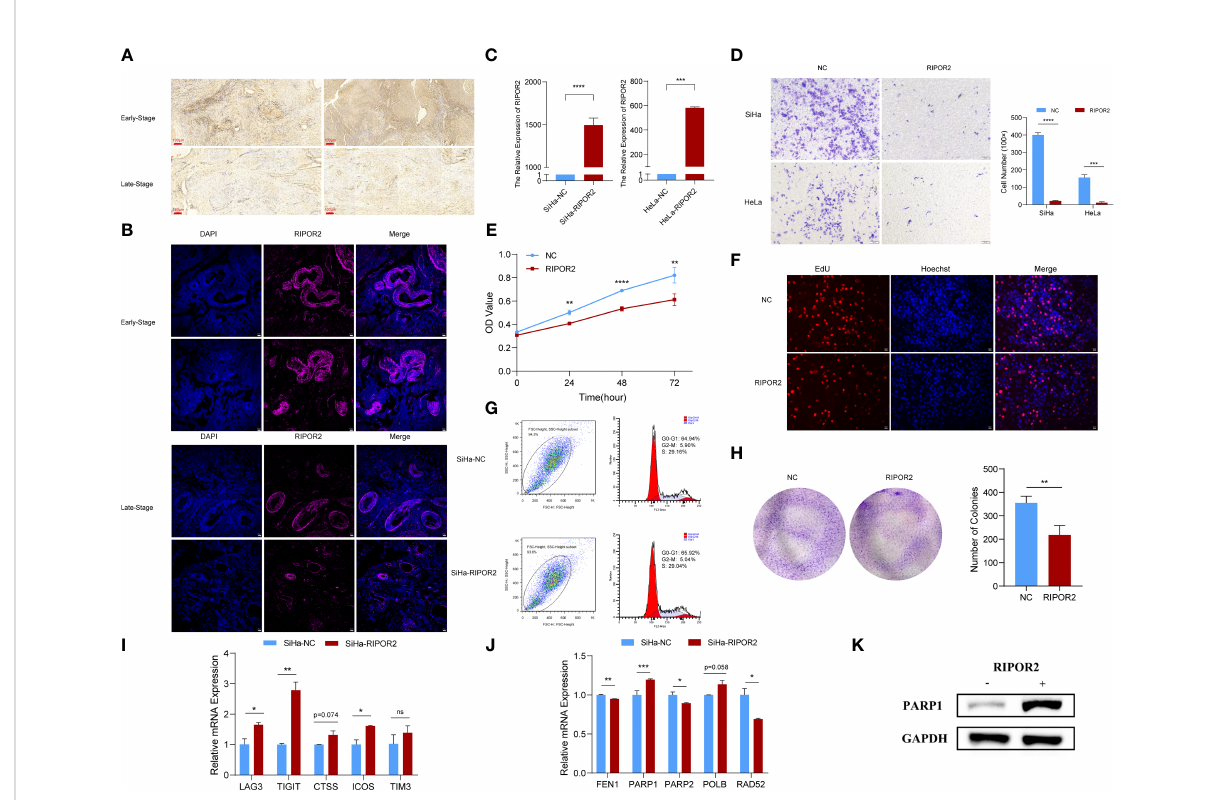
FIGURE 8 Functional experimental veri fi cation of RIPOR2. (A) The expression of RIPOR2 protein in early- and late-stage cervical cancer tissues was detected by Immunohistochemistry (IHC), Scale bar, 100 m m. (B) Immuno fl uorescence (I, F) staining results of RIPOR2 protein in early- and late- stage of cervical cancer tissues. Scale bar, 25 m m. (C) The expressing amount of RIPOR2 differed in the control cell lines and overexpression transfected cell lines, both in the SiHa group with p-value <0.0001(****) and the HeLa group with a p-value <0.001(***). (D) The results of the transwell assay, pictures on the left show the CC cell distributions of groups photographed in different visual fi elds. “ NC ” means normal control with pcDNA3.1 (empty vector) transfection; “ RIPOR2 ” represents a group with overexpression plasmid transfection. The result of differential analysis based on cell number was shown in the bar plot. (E) It is shown that at times of 24, 48, and 72 h, the HeLa cells living in the normal control group are always signi fi cantly greater than the RIPOR2-overexpressed group by CCK-8 (p-value: **p <0.01, ****p <0.0001). (F) EdU assay was used to detect the proliferation ability of each group of SiHa cells. Scale bar, 100 m m. (G) Flow cytometry analysis showed overexpression of RIPOR2 in SiHa cells slightly increased the percentage of the G0/G1 phase cells and decreased the percentage of S and G2/M phage cells. (H) Colon formation assay was performed to determine the proliferation ability of each group of cells. The bar plot showed the number of colonies in SiHa cells, with p <0.01 (**). (I) Inferred from RT-qPCR, checkpoints LAG3, TIGIT, CTSS, ICOS, and TIM3 showed correspondingly high expression in the SiHa cell lines transfected with RIPOR2-overexpressing plasmids. (J) RT-qPCR results indicated that FEN1, PARP2, and RAD52 negatively correlated with RIPOR2, PARP1 expressed more in the SiHa-RIPOR2 group, and POLB got a higher expression amount in the RIPOR2 group however with p-value = 0.058. (K) “ − ” represents the normal control group, while “ + ” is for the RIPOR2- overexpressed cluster. The protein level of PARP1 is much stronger with RIPOR2-overexpression of SiHa cells, which corresponds to the results of the RNA